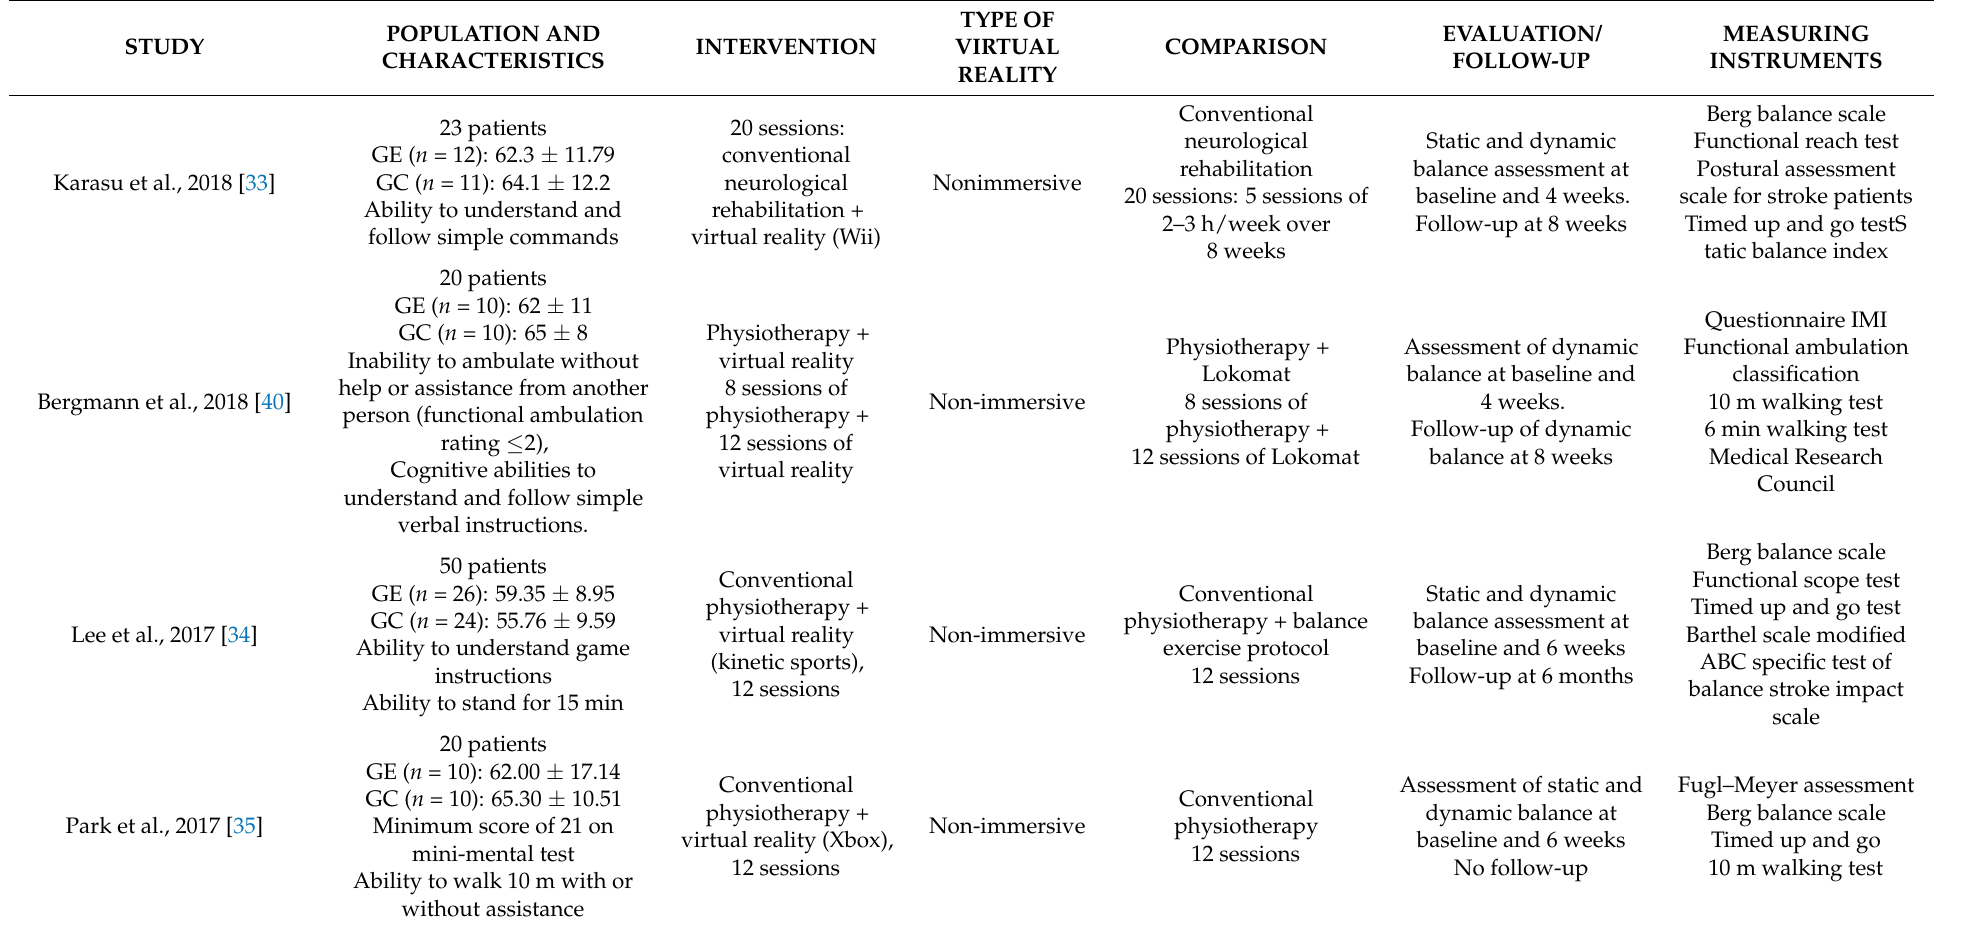
Table 2. Studies included in the